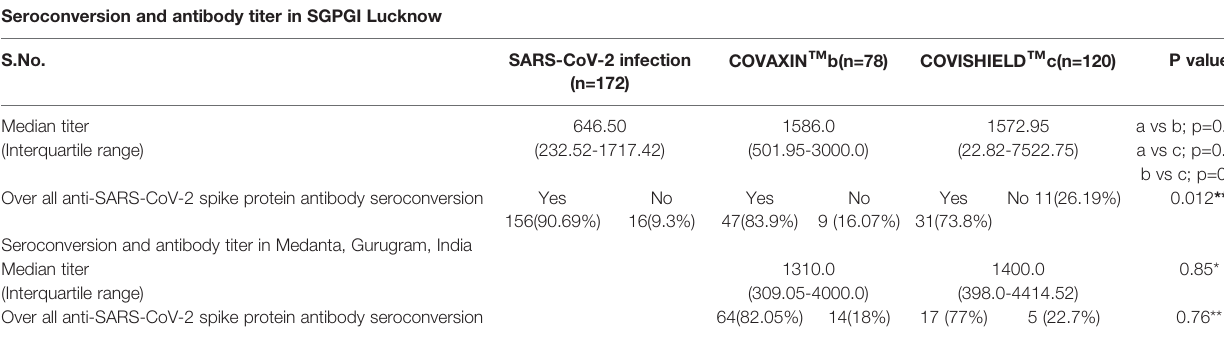
$- Indicates seroconversion in patient who had anti SARS-CoV-2 Spike protein antibody titer >50AU/ml. *Kruskal Wallis Test, **Chi Square test.